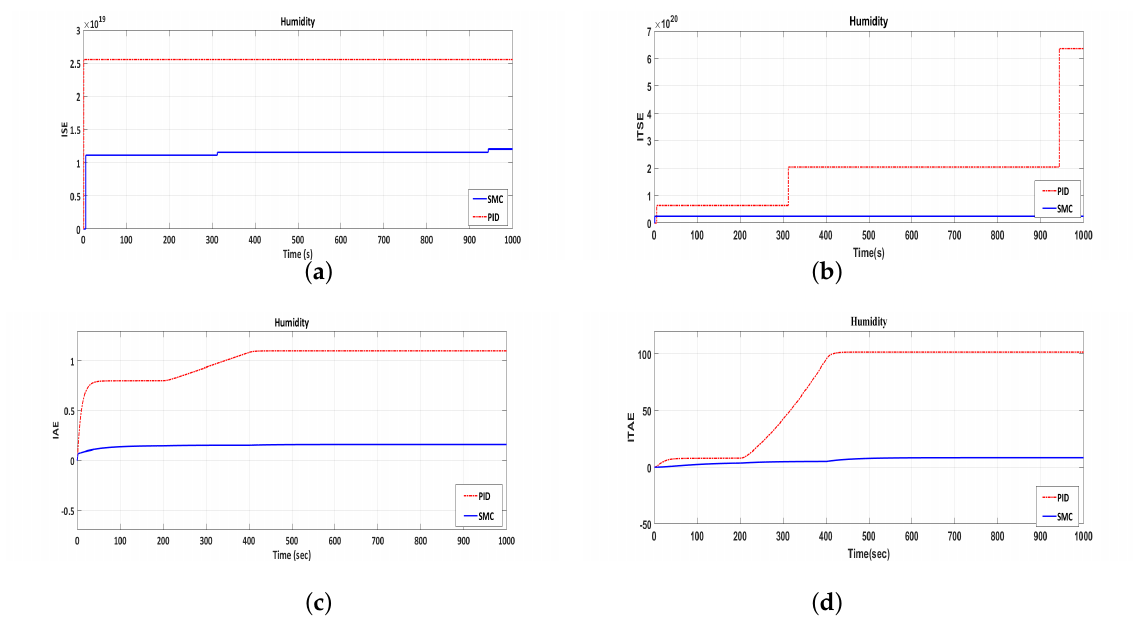
Figure A4. Performance indices ( a ) ISE, ( b ) ITSE, ( c ) IAE, ( d ) ITAE graph of controllers for humidity output of the second reference signal, ramp with steps.